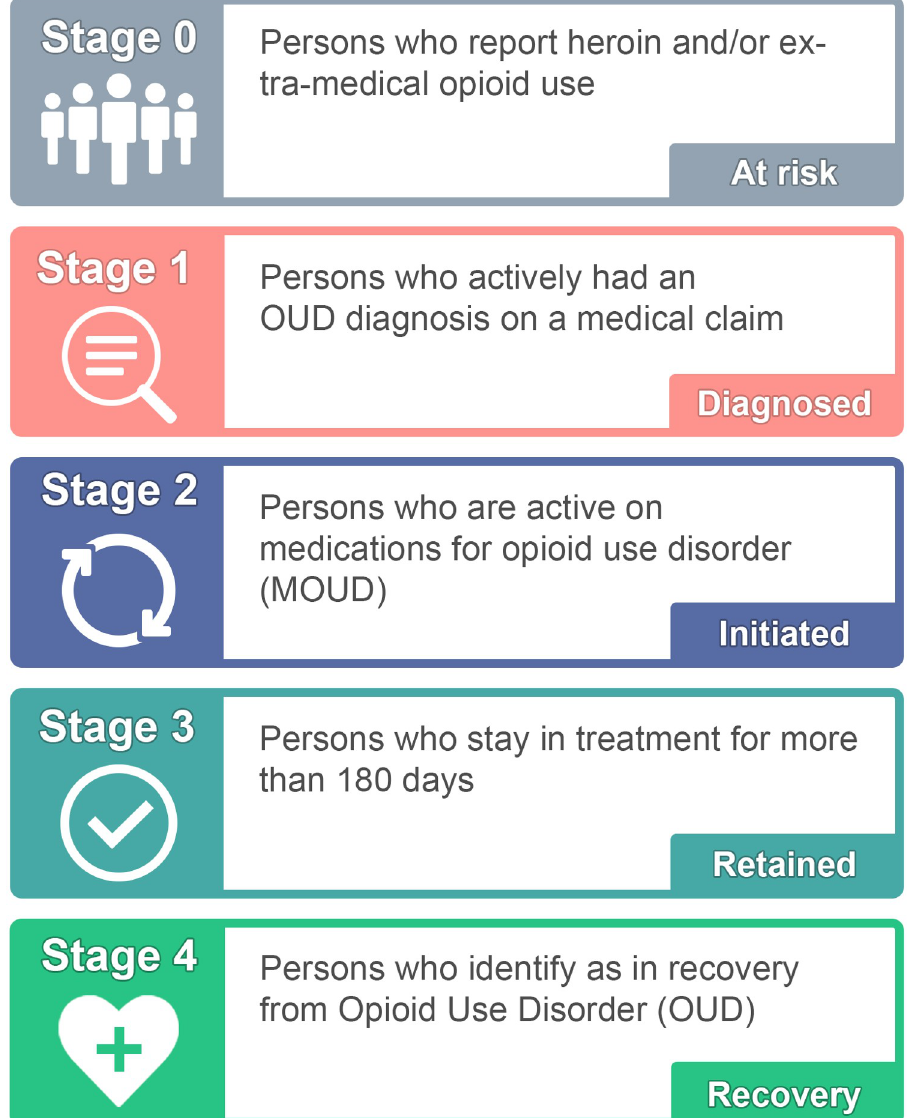
Fig 1. Overview of the Rhode Island model for the cascade of care for opioid use disorder (OUD). Credit: Maxwell Krieger, Brown University.